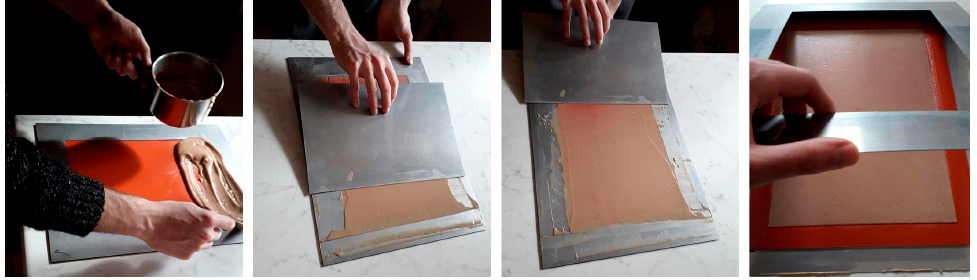
Figure 2. The different phases of the film casting. Figure 2. The di ff erent phases of the film